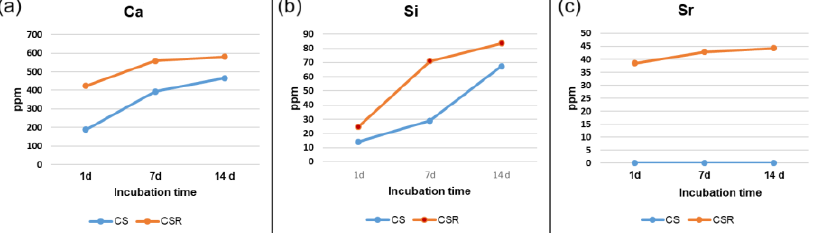
Figure 8. Ion release of Ca ( a ), Si ( b ), and Sr ( c ) in both CS and CSR using ICP-OES. The ion release of Ca, and Si was higher in CSR than in CS with gradual increase with time in all groups. Sr release also increased with immersion time in CSR. No Sr was detected in